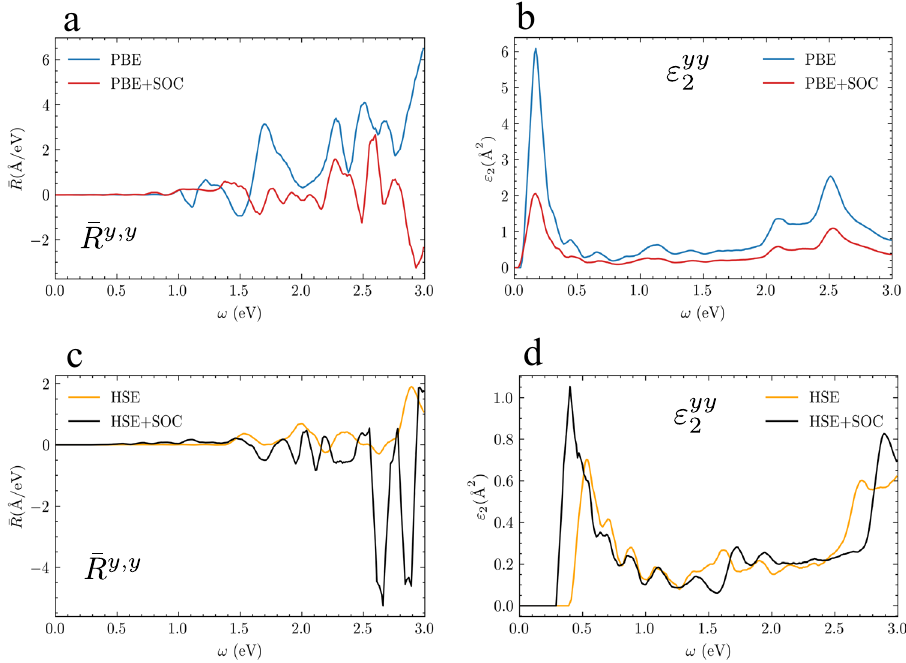
y ; y ) and transition intensity ( ε yy estimated with b PBE and PBE + SOC and d HSE and HSE 2